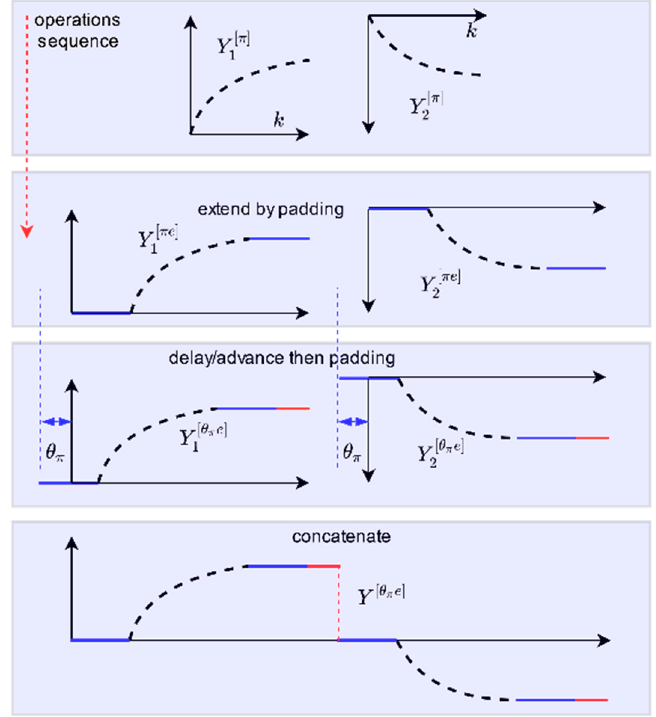
Figure 1. Extension with padding, delay with padding and final concatenation concepts, in the space of two output primitives. Similar operations are performed for the input primitives. Algorithm 2 is entirely performed offline, not impacting the real-time control task.